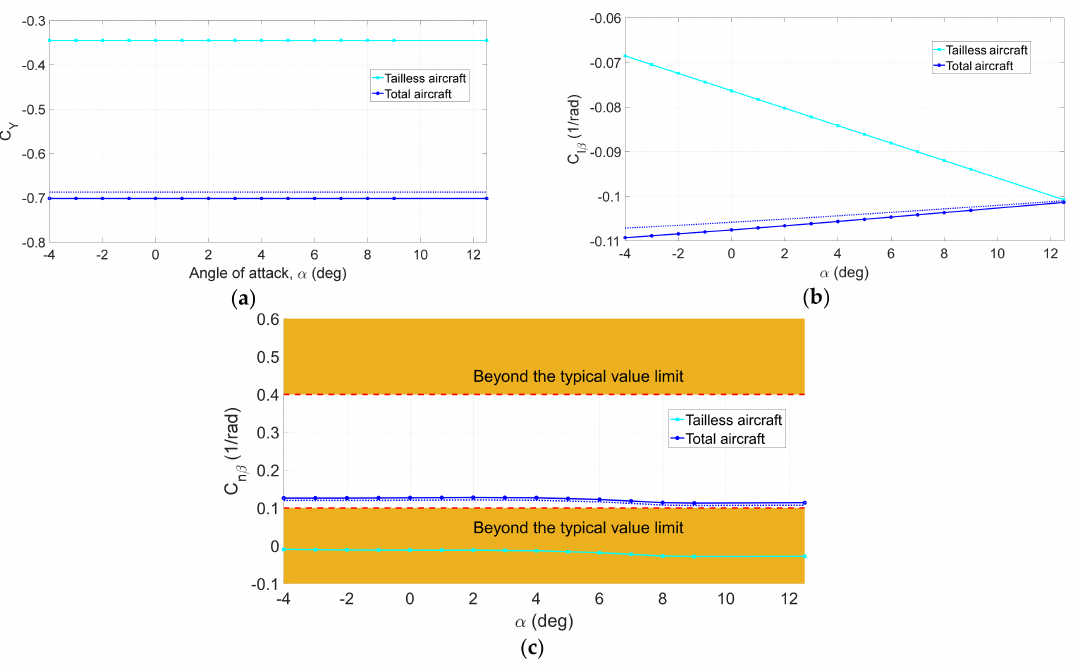
Figure 9. Lateral-directional static characteristics of the proposed twin-engine aircraft model: ( a ) side- force derivative results for the cruise condition; ( b ) effective dihedral coefficient results for the cruise condition; ( c ) weathercock stability coefficient results for the cruise condition; (solid lines account for the optimization using mass minimization scenario and dotted-lines are for drag optimization in trim flight).